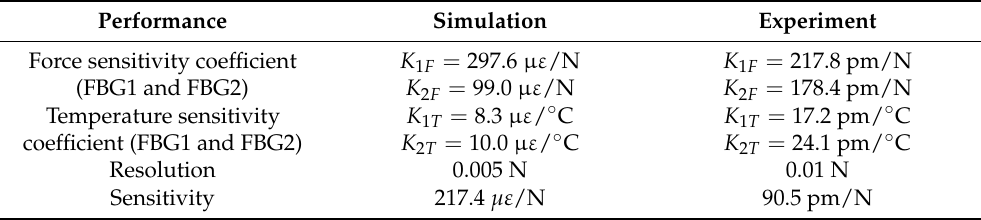
Table 3. Comparison of simulation and experiment performance